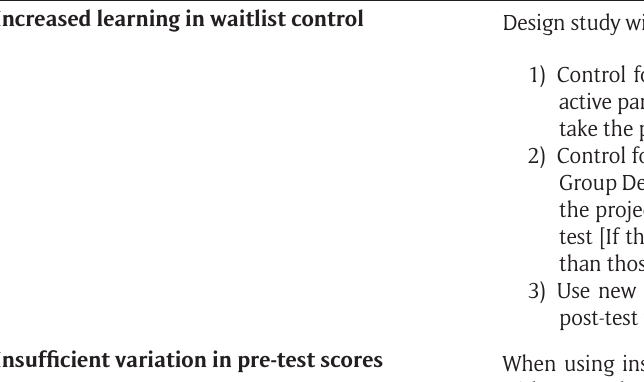
Table 7: Recommendations for how to proceed with controlled studies of online